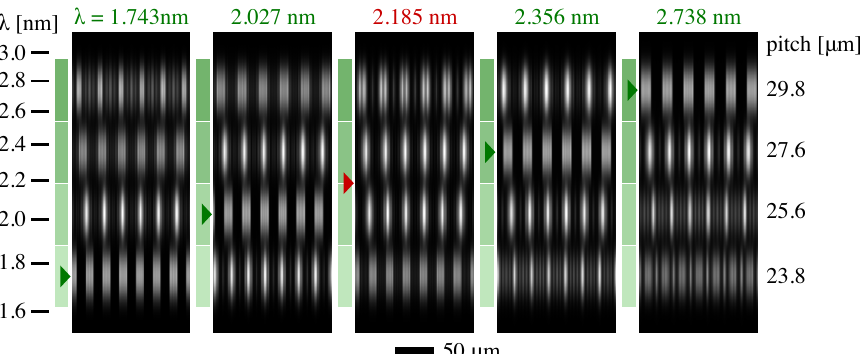
Figure 8. Modeled shearing detector-plane intensity patterns. The four gratings of Column 2 are illuminated with wavelengths shown above each detail. Grating pitch values are shown on the right. Square-wave intensity patterns are reproduced at the four design wavelengths (green markers), while the intermediate wavelength (red marker) shows that gratings from the two middle rows can both be used. The green colored rectangles align to the scale at the left and show the wavelength ranges over which each grating is designed to be